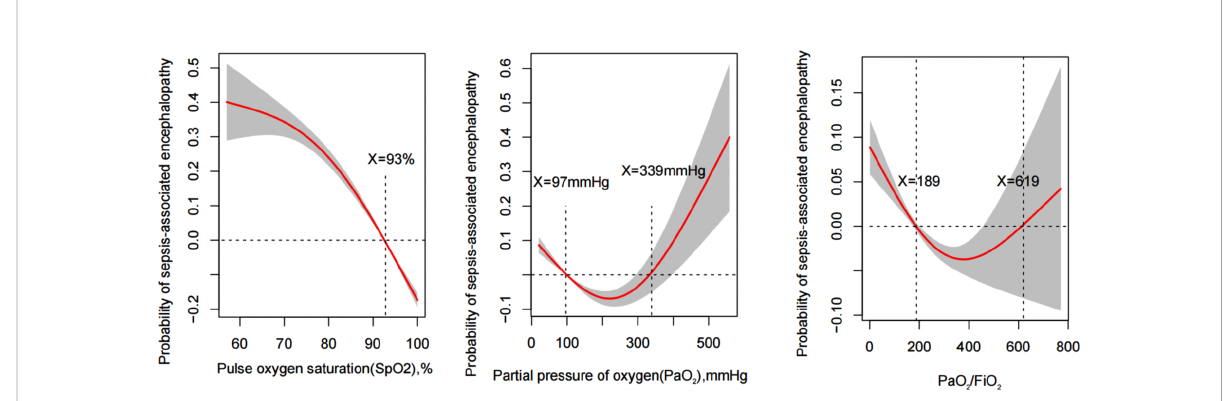
FIGURE 2 Generalized additive model plots for the median of S P O 2 , PaO 2 , and PaO 2 /FiO 2 indicating the probability of sepsis-associated encephalopathy